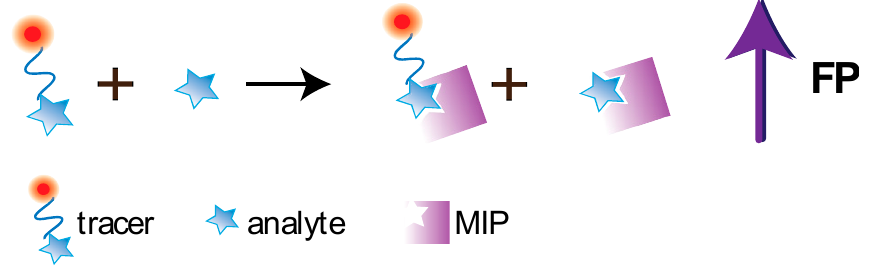
Figure 7. Principle of the competitive FPA using MIP.